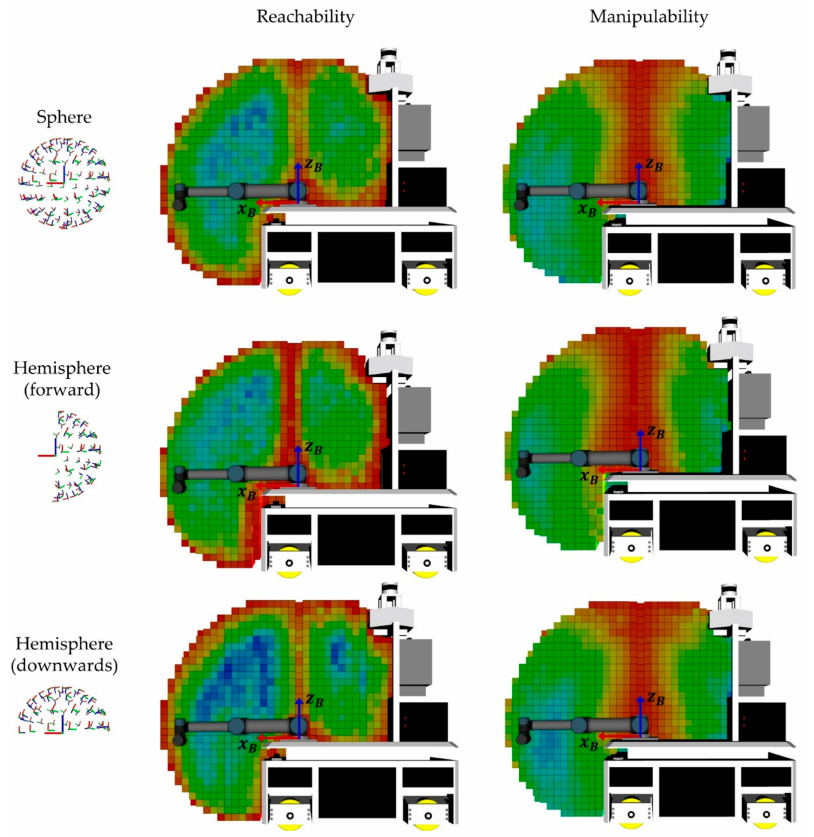
Figure 23. Workspace analyzing divided into reachability and